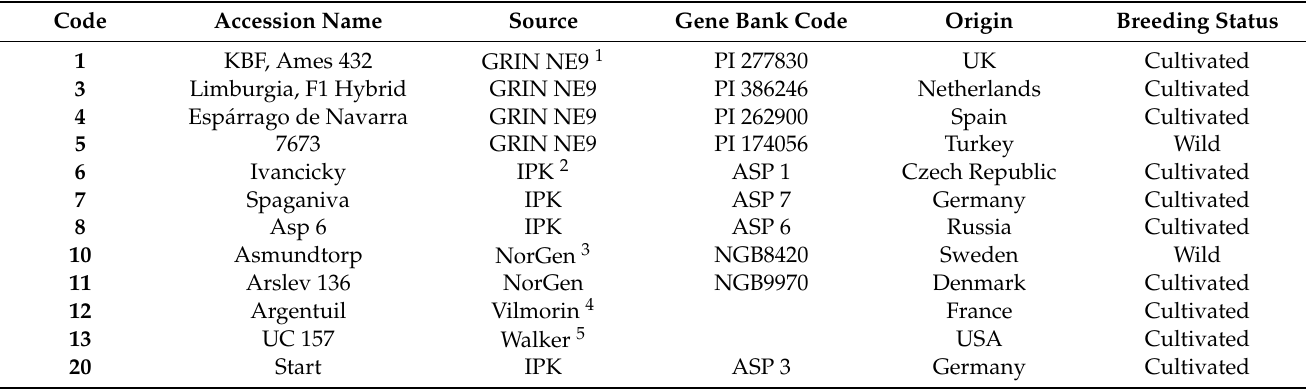
Table 1. List of asparagus accessions used as parents of experimental hybrids and in per se